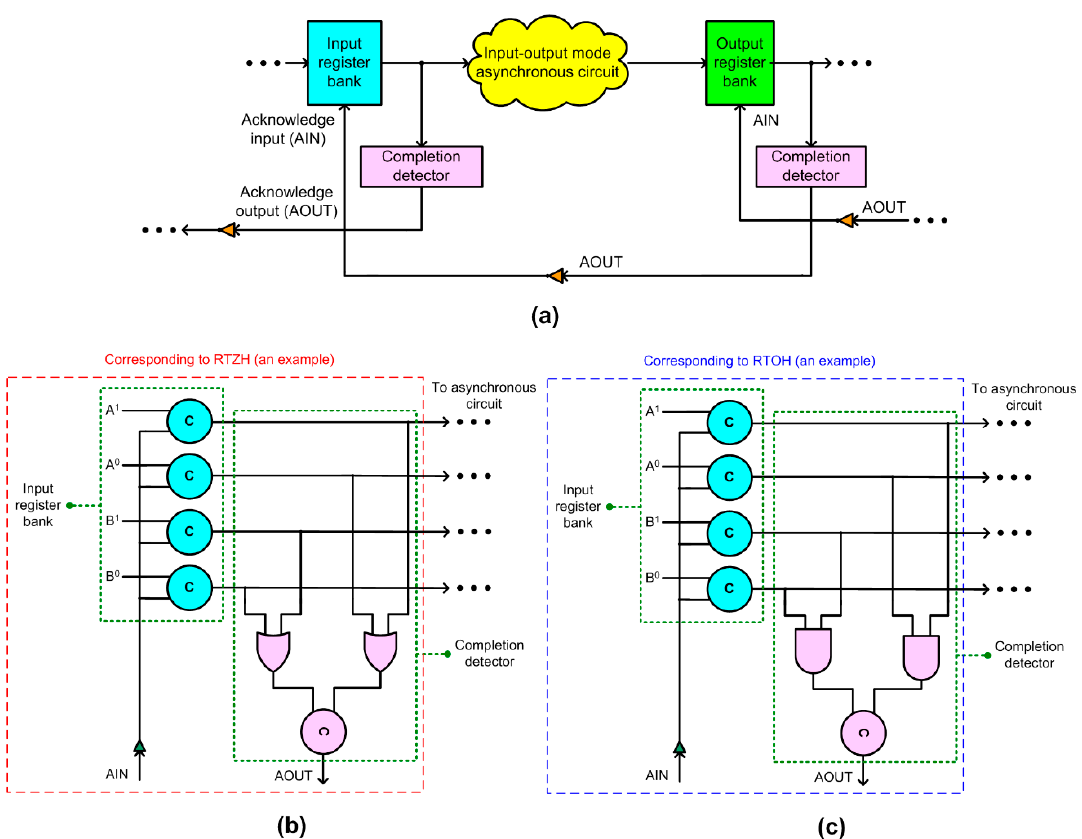
Figure 1. ( a ) Block diagram of an input-output mode asynchronous circuit stage. Example illustration of input register bank and completion detector corresponding to: ( b ) RTZH and ( c ) RTOH.